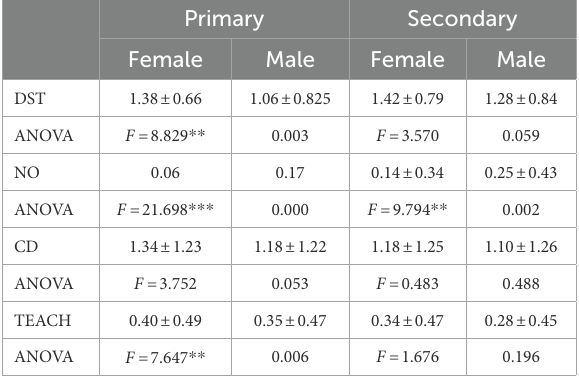
TABLE 2 Descriptive statistics of quantitative drawing indices and differences by sex and type of school.